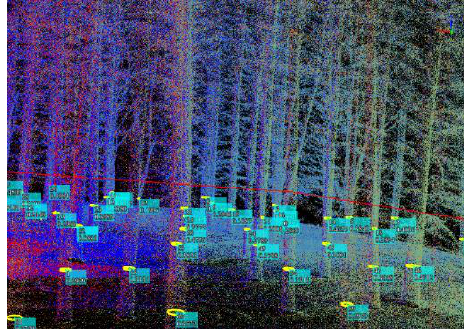
Figure 2.b The star scheme of walking path used for mobile laser scanning.